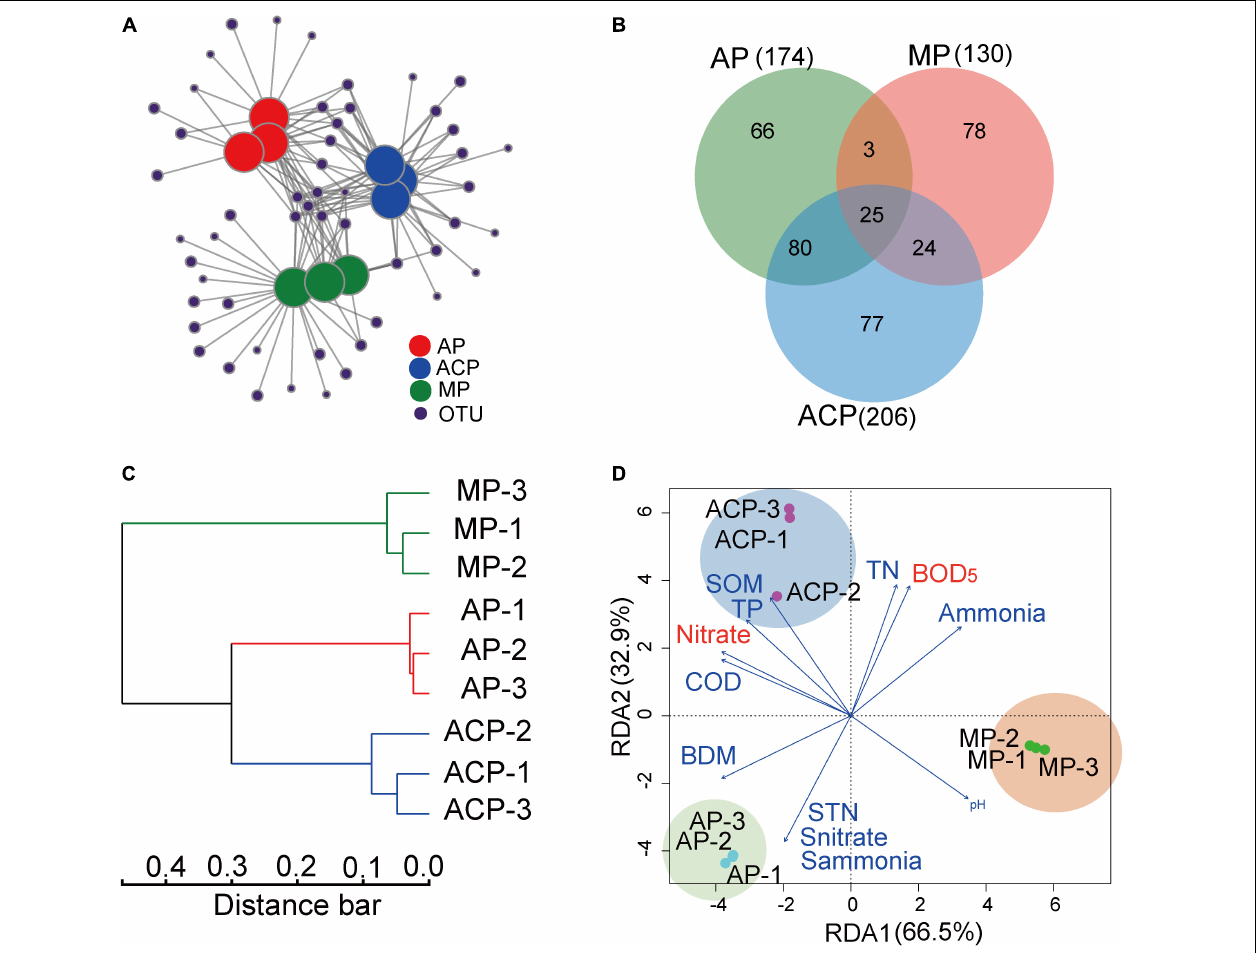
FIGURE 5 | OTU profiles in response to solid waste decomposition phases and the impact of parameter factors on the methanogen community structure based on OTU distribution. (A) Network analysis of OTUs in solid waste samples between aerobic phase (AP), anaerobic acid phase (ACP), and methanogenic phase (MP). (B) The shared OTUs in solid waste samples among AP, ACP, and MP. (C) Hierarchical clustering analysis on bacterial community composition (OTUs level) based on Bray–Curtis distance. (D) Redundancy analysis (RDA) of the link between methanogen community structures and physiochemical parameters of leachate and solid waste. The variables significantly influencing methanogen community structure selected by the forward selection procedure were fitted to the ordinations with red color. AP, aerobic phase ( n = 3); ACP, anaerobic acid phase ( n = 3); MP, methanogenic phase ( n = 3). STN, TN of solid waste; Snitrate, nitrate of solid waste; Sammonia, ammonia of solid waste; SOM, organic matter of solid